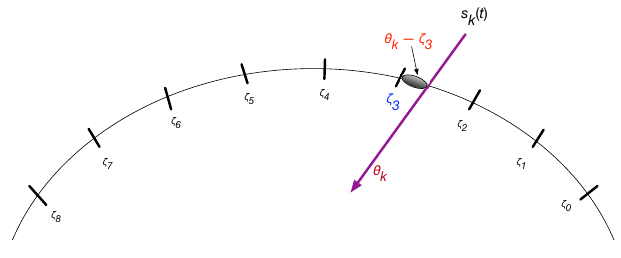
Figure 2. The structure of sparse matrix X .